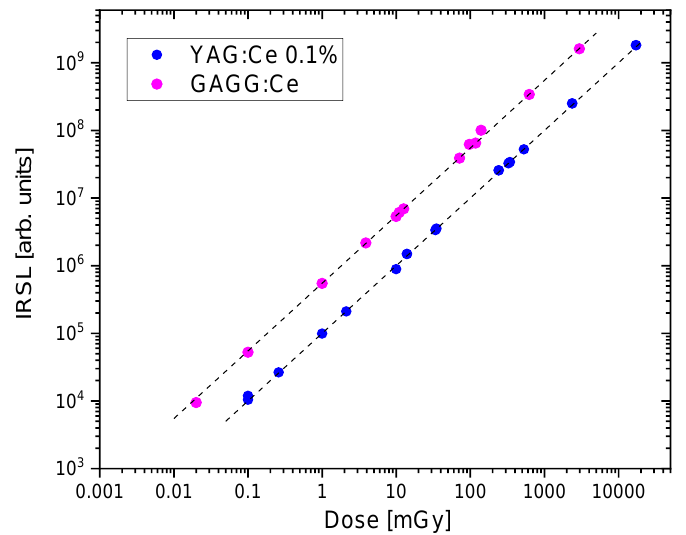
Figure 15. Fading of the IRSL signal during storage time after irradiation. The data are normalized to the first measurements, which were performed 10 min after the exposure. The lines are drawn only to guide the eye. Dose 1 Gy.